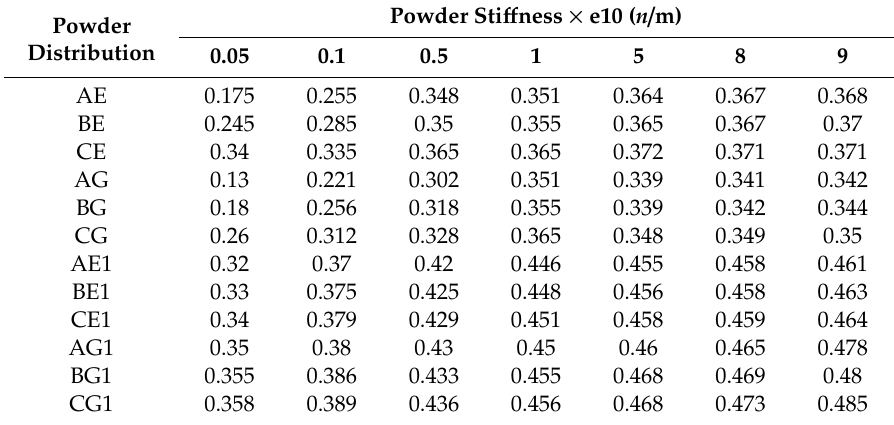
Table1. Porositymeasurementresultsatdi ff erentdepthsofthecontainerunderdi ff erentsti ff nessvalues. Powder